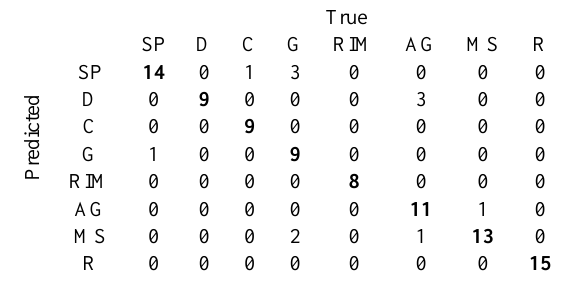
of 100 observa- val